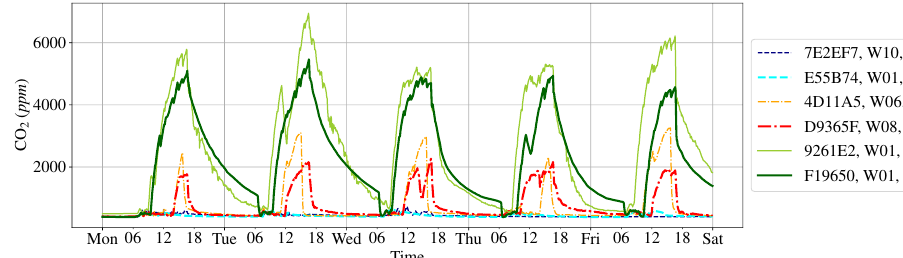
Figure 17. Raw data cluster result sample.